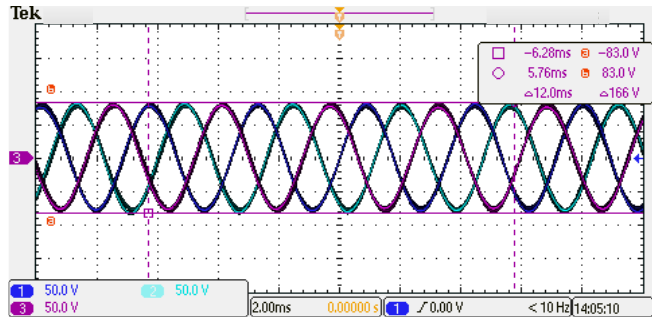
Figure 22. Measured back-EMF at speed of 600 r/mim.